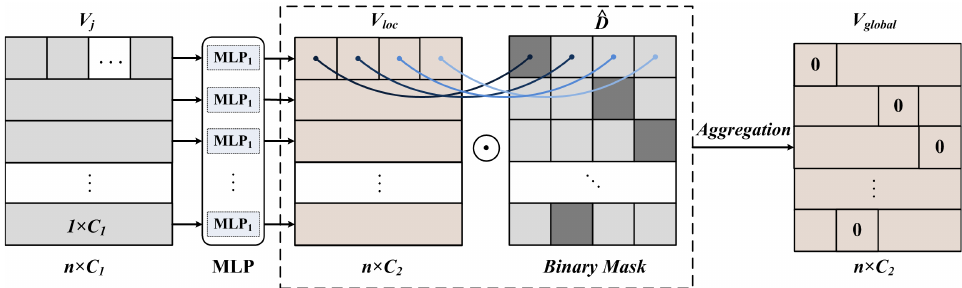
Figure 2. The dynamic sparsification-based point cloud processing. Firstly, we define the expression of the voxel grid as v i ∈ R n × C 1 . Secondly, to ensure the invariance of the point cloud structure in the spatial domain, the local voxel feature v loc ∈ R n × C 2 is obtained by mapping the voxel feature v i ∈ R n × C 1 using MLP. This feature includes the number of voxel grids and the number of points contained in the grid. Then, according to the number of points contained in the grid sort the voxel grid, the binary mask ˆ D is obtained. Finally, the local voxel feature expression v l oc and the binary mask ˆ D are aggregated to obtain the global voxel feature v global ∈ R n × C 2